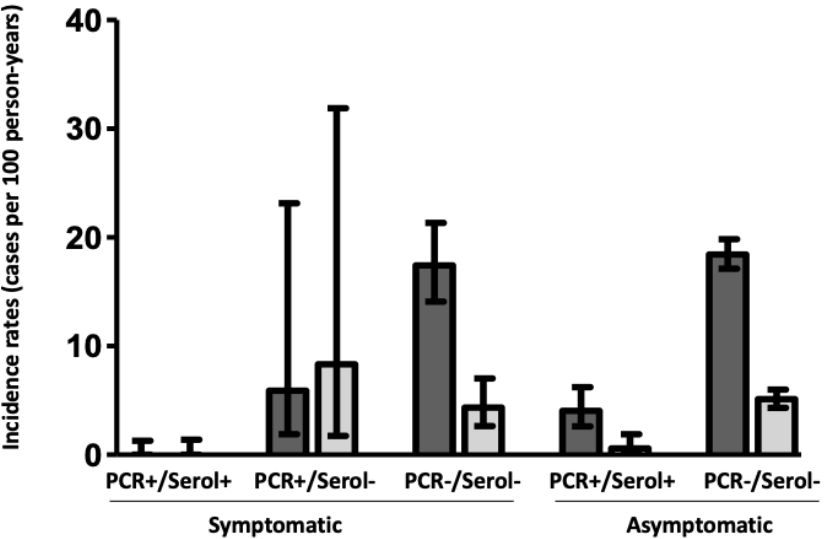
Figure 2. Incidence rates (95% confidence interval) of new infections/reinfections in the period before vaccination (dark grey bars) and after vaccination (grey bars), globally and according to positive (IgG+) or negative (IgG  ) anti-N specific serology during the first wave of the disease.